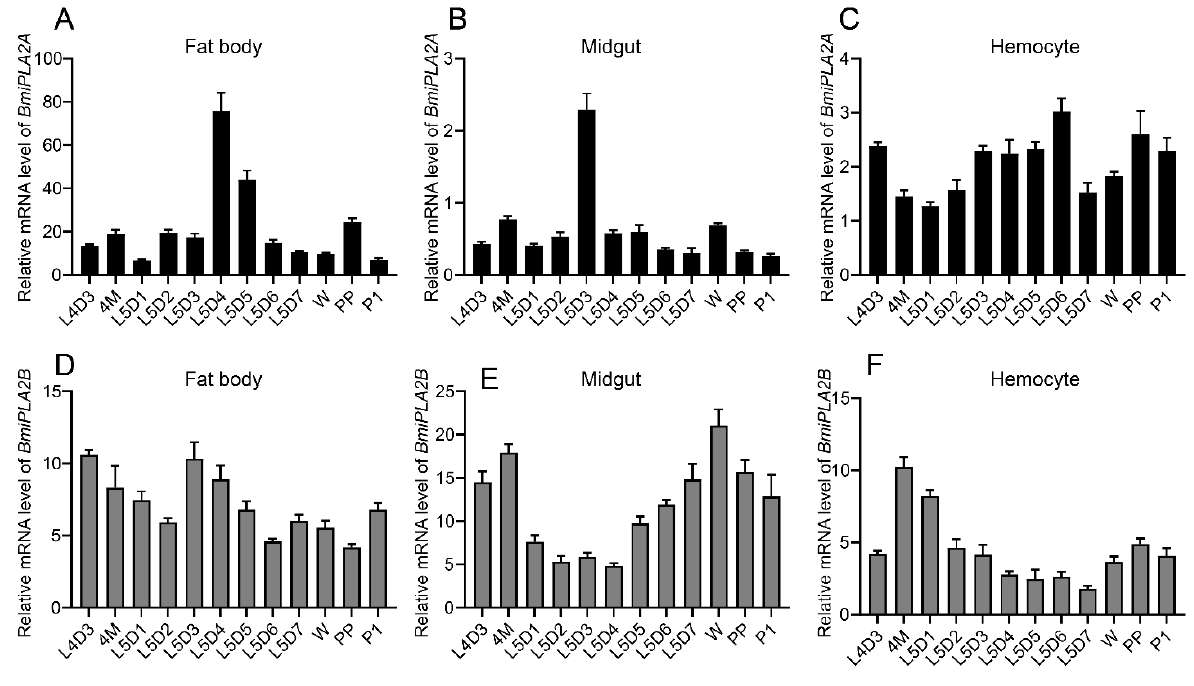
Figure 5. The temporal expression profiles BmiPLA2A and BmiPLA2B in the fat body ( A,D ), midgut ( B,E ), and hemocyte ( C,F ) from fourth instar day 3 (L4D3) to the pupal stage. 4M: fourth molting stage, W: wandering stage, PP: pre-pupa stage, P1: day 1 of pupa stage.